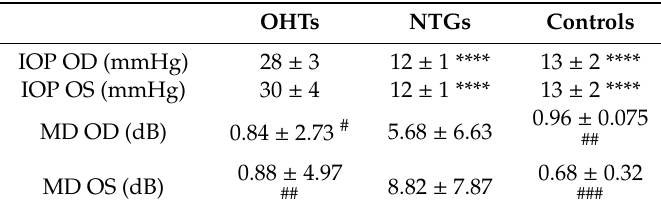
Table 2. General ophthalmological data of